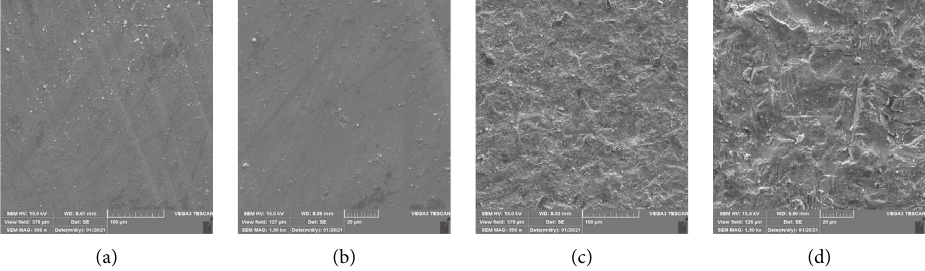
Figure 5: High-translucent zirconia SEM micrograph: (a, b) without APA and (c, d) with APA ( × 500 and × 1500